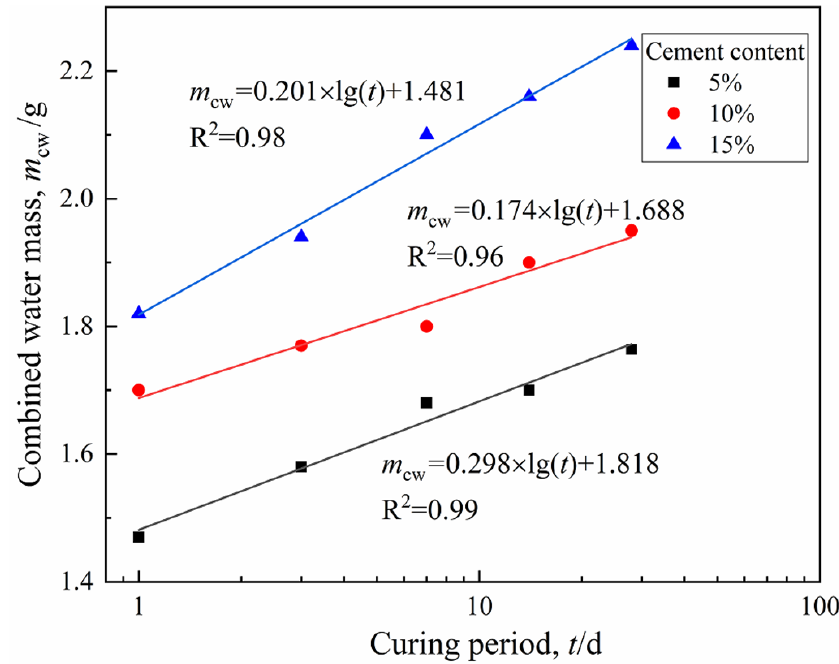
Figure 5. Relationship between CW mass and curing period.